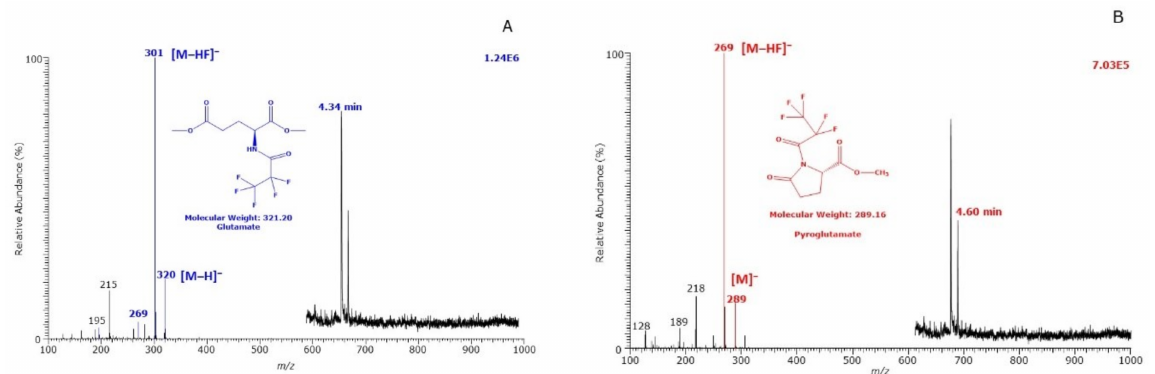
Figure 3. Mass spectra in the ECNICI mode and chromatograms (inserted) of the two GC-MS peaks, with the retention times 4.34 and 4.60 min, obtained from the derivatization of synthetic pyroglutamate (10 nmol) after its esterification (20 min, 80 ◦ C) in 2 M HCl/CH 3 OH and subsequent acylation with PFPA (30 min, 65 ◦ C). The GC-MS peak eluting at 4.34 min ( A ) was identified as the glutamate (Glu) derivative. The GC-MS peak with the retention time 4.60 min ( B ) is most likely due to the Me-PFP derivative of pyroglutamate (pGlu). Oven temperature program TP#1 was used. The quadrupole was scanned in the m / z -range 100–1000 (1 scan/s). Inserts indicate the proposed structures for selected mass fragments. M, molecular mass of the